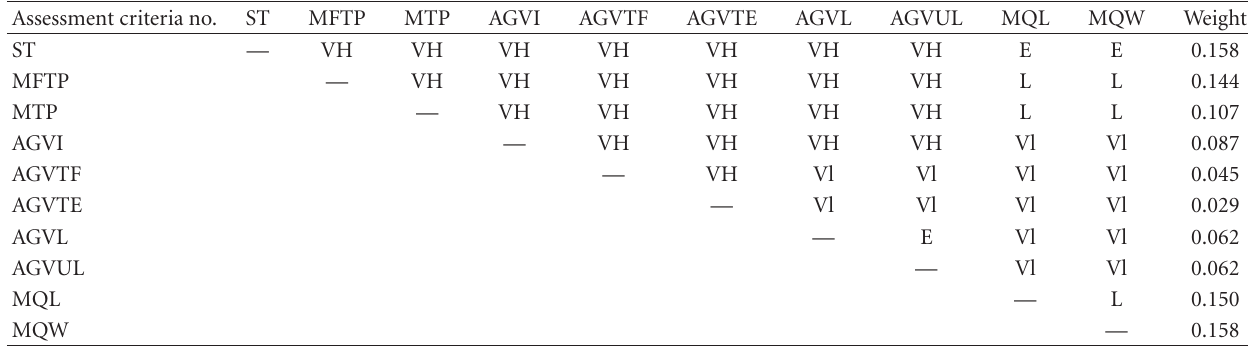
Table 6: Criteria comparison matrix.